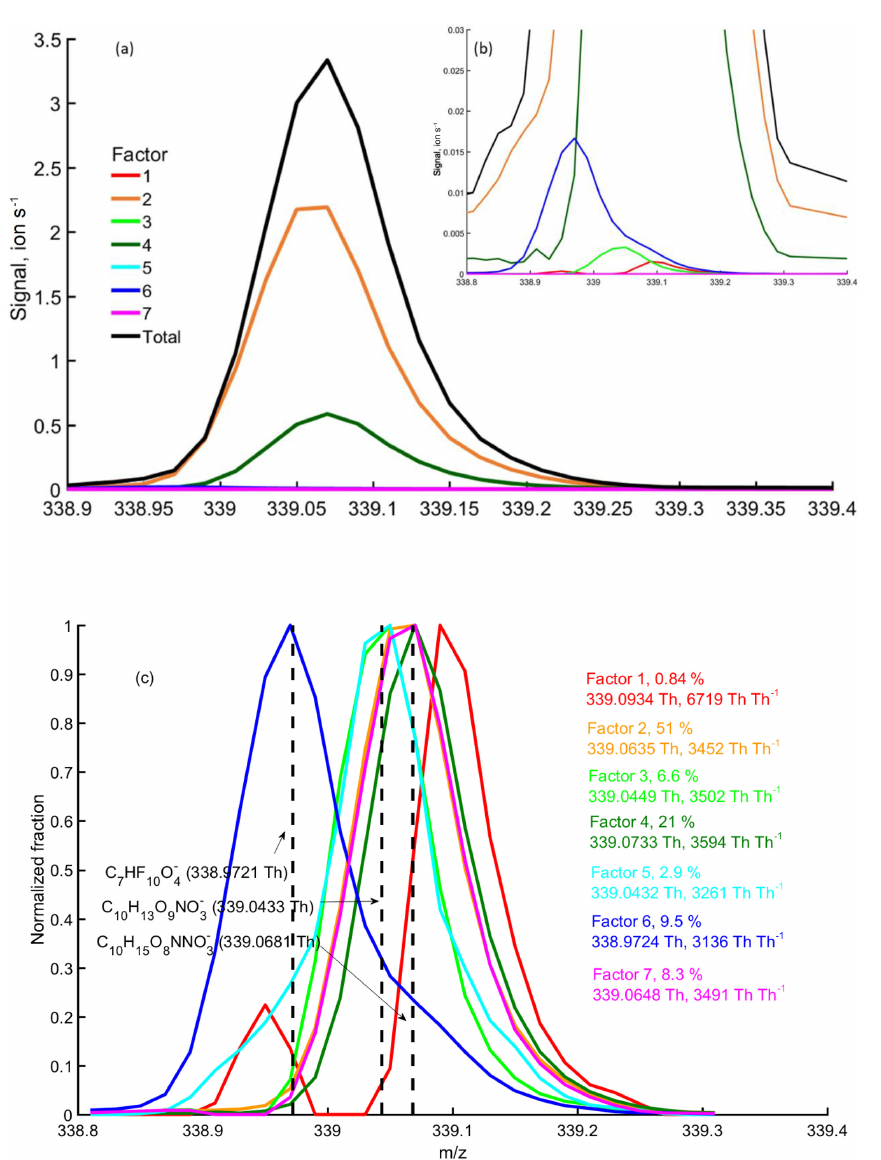
Figure 9. binPMF factor profiles at m/z 339Th at 12:00 on 9 September. Panels (a) and (b) show the absolute concentrations of each factor, while in panel (c) the factor profiles are normalized to the same maximum peak heights. The fitted peak location (Th) and the apparent resolution (ThTh − 1 ) for each factor are given in panel (c) . The contribution of different factors to the integer m/z 339Th is shown as a percentage. Three potential chemical compositions were marked with black vertical dashed